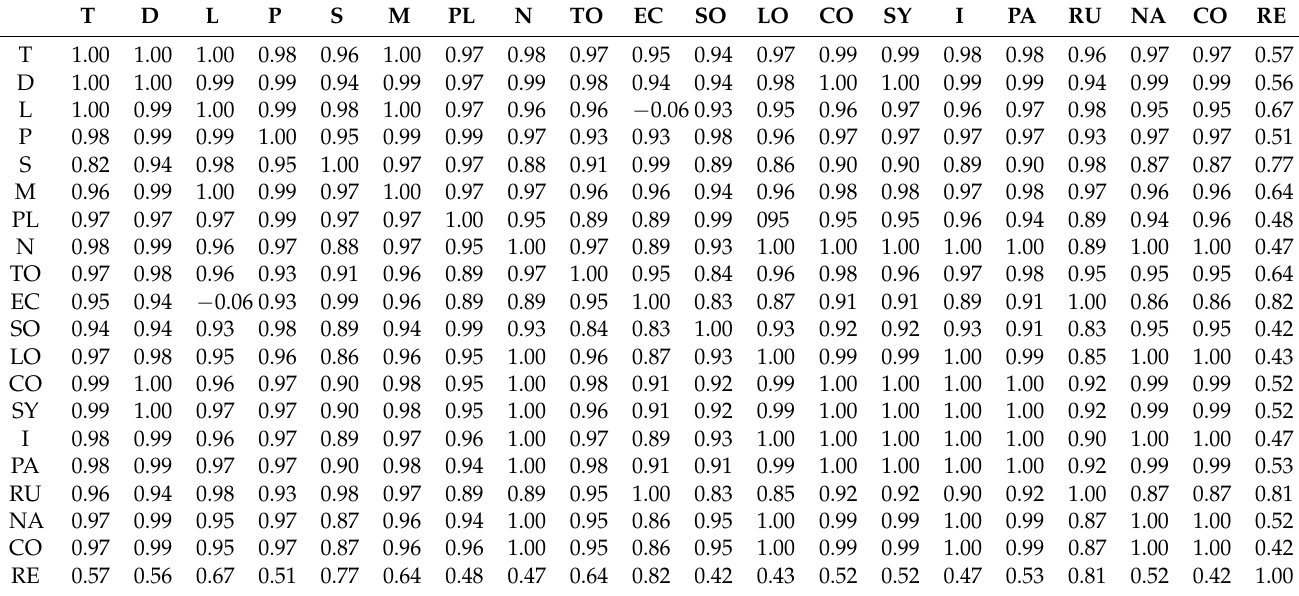
Table 5. Correlations between the most common topics investigated in tourism and planning in natural